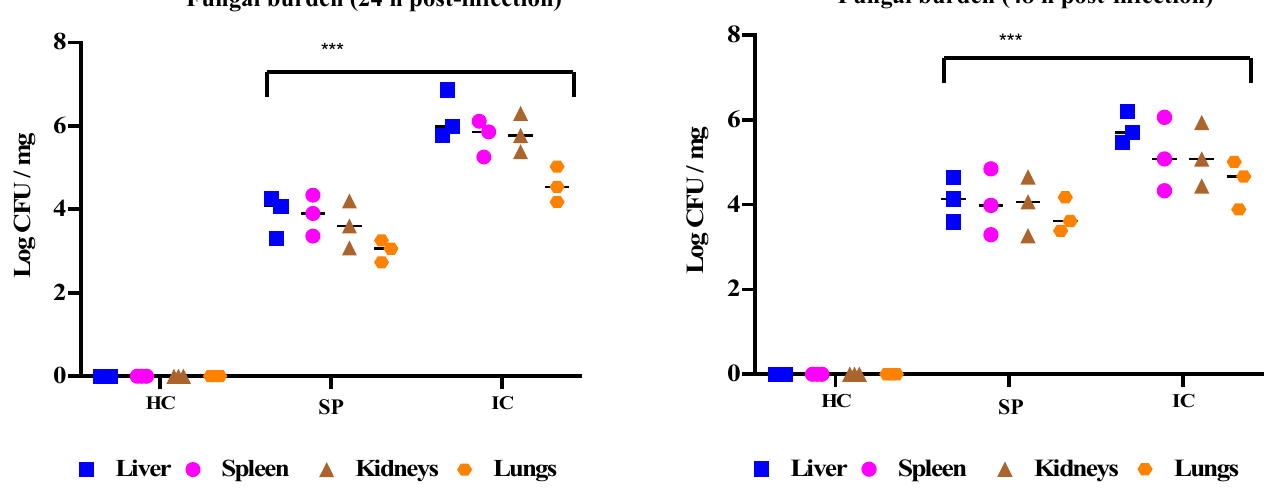
Figure 6. The protective effect of the C. glabrata secretome against fungal burden. Post infection immunized and infection control mice were sacrificed, and liver, spleen, kidneys, and lungs were harvested and subjected to fungal burden determination. The fungal burden was expressed as geometric means of logarithmic values for CFU/mg of tissues. HC, healthy control group; SP, secreted proteins; IC, infection control. *** p = 0.0043.